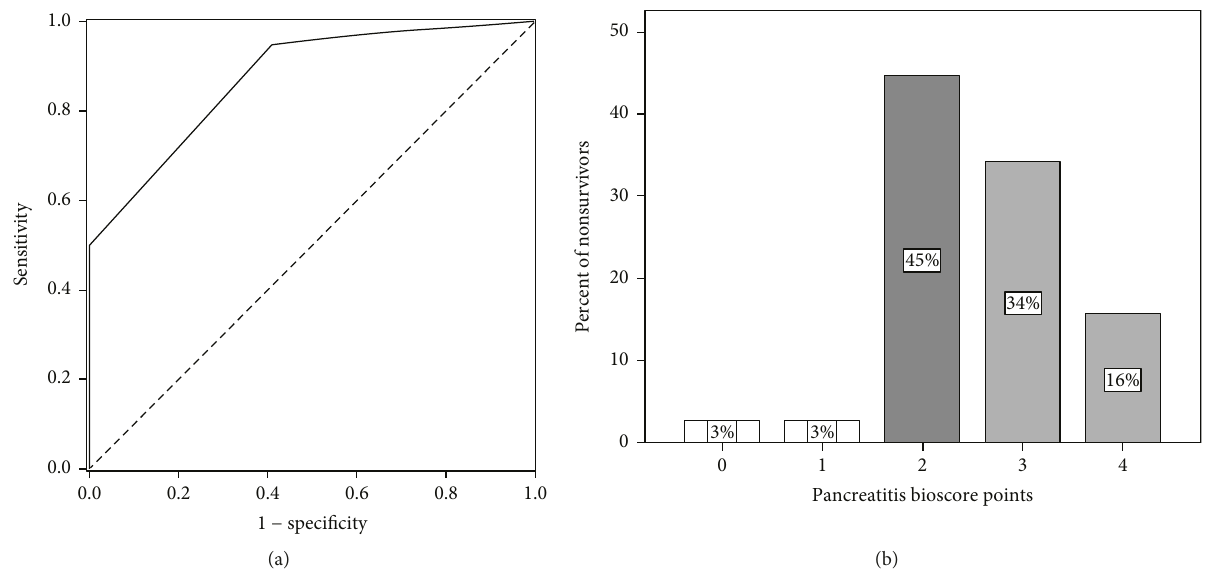
Figure 1: (a) Receiver operating characteristic (ROC) curve for composite bioscore in the pancreatitis subgroup and the lethal outcome (AUC =0.874). (b) Percentage of nonsurvivors according to each bioscore point value in the pancreatitis subgroup (darkest shade: cut-o ff bioscore point value).